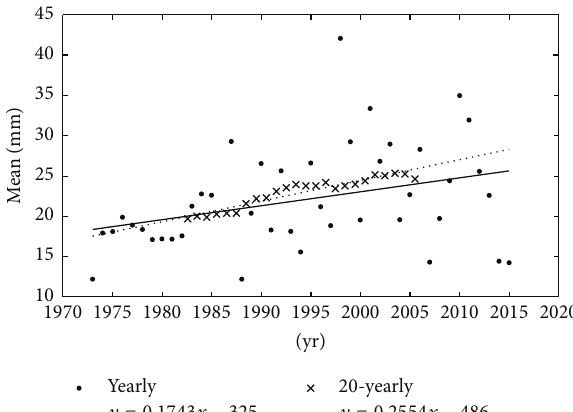
Figure 10: Time series of the mean of the top-five 1-hour yearly peak precipitation observed at Seoul observation station. Dots are the yearly mean values, and crosses are the 20-year moving window mean values. Solid and dotted lines are the least square fit linear regression line of the yearly and 20-yearly mean values, respectively.